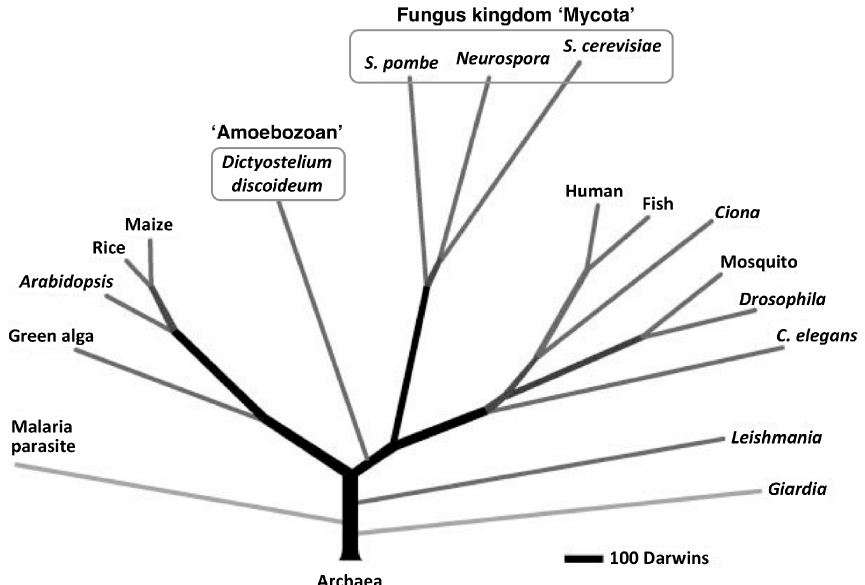
Figure 1. Proteome ‐ based eukaryotic phylogeny (adapted with permission from Eichinger et al. [6]). The phylogenetic tree was constructed from a database of 5279 orthologous protein clusters that were drawn from 17 eukaryotic proteomes, including that of Dictyostelium discoideum , which was rooted on 159 protein clusters that had representatives from six archaebacterial proteomes: Plasmodium falciparum , malaria parasite; Chlamydomonas reinhardtii , green alga; Oryza sativa , rice; Zea mays , maize; Fugu rubripes , fish; Anopheles gambiae , mosquito.